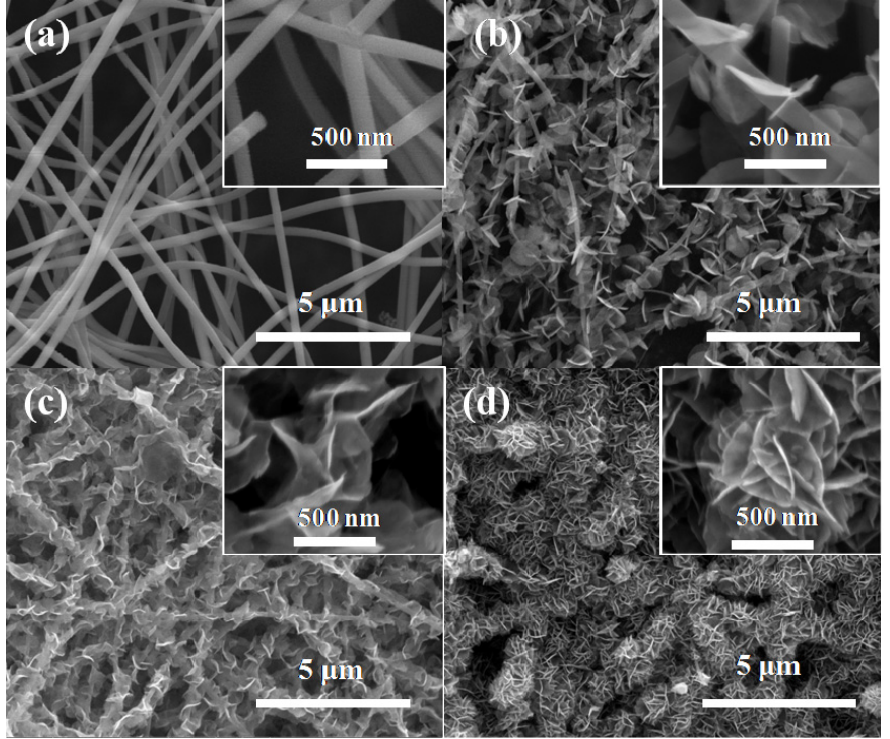
Figure 1. ( a ) SEM images of TiO 2 nanofibers; ( b ) BiOI/TiO 2 ‐ C10; ( c ) BiOI/TiO 2 ‐ C20; and ( d ) BiOI/TiO 2 ‐ C30 at low magnification and high magnification (insets).